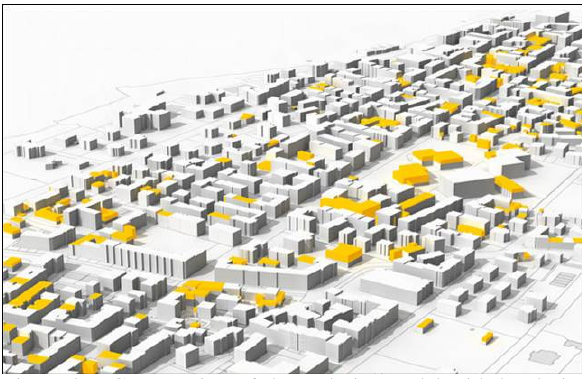
Figure 3 – Comparation of the real city model with legal city